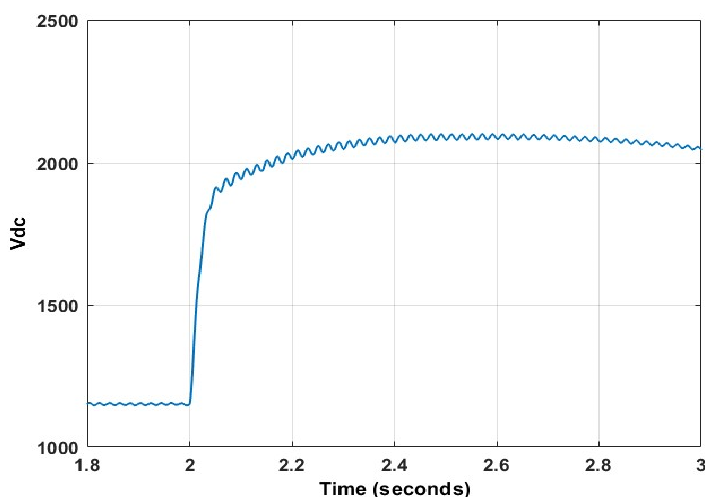
Figure 50. DC voltage transient using DCI at 90% dip.